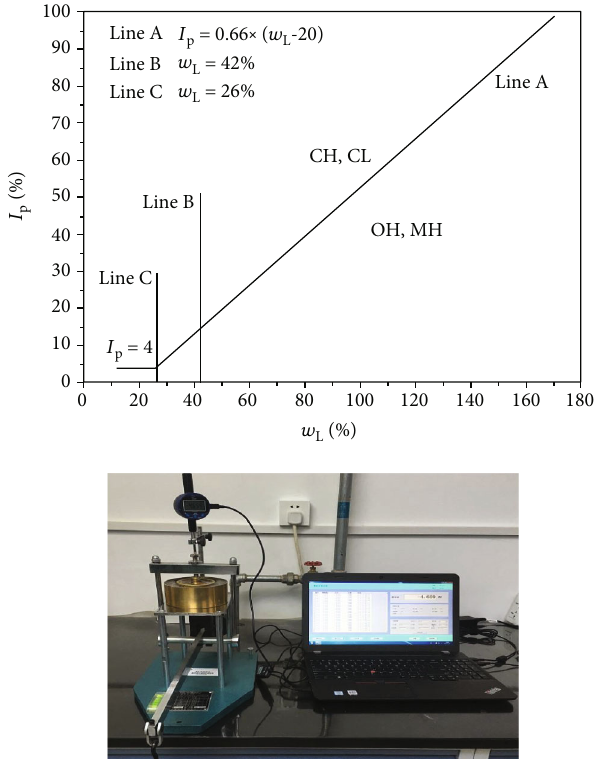
Figure 7: Consolidation apparatus of